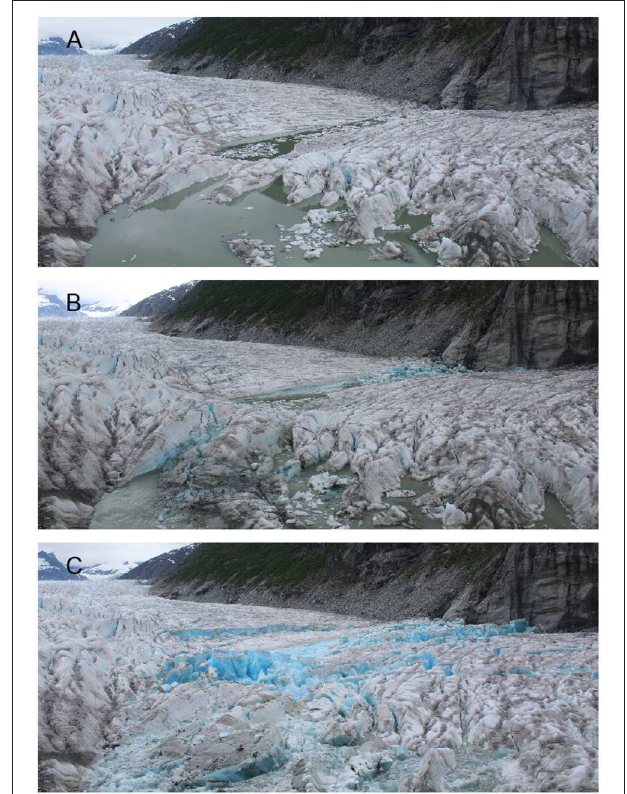
FIGURE 8 | Time-lapse photos taken (A) before, (B) during, and (C) after Suicide Basin’s floating ice tongue detached from the trunk glacier on 25 June 2018. Prior to the event, portions of the ice tongue were submerged entirely and thus superbuoyant. During the event, which occurred over a 15 min period, the ice rose by up to 10 m, and moved 25 m into the basin. Simultaneously, the water level in the basin dropped by 0.75 m.